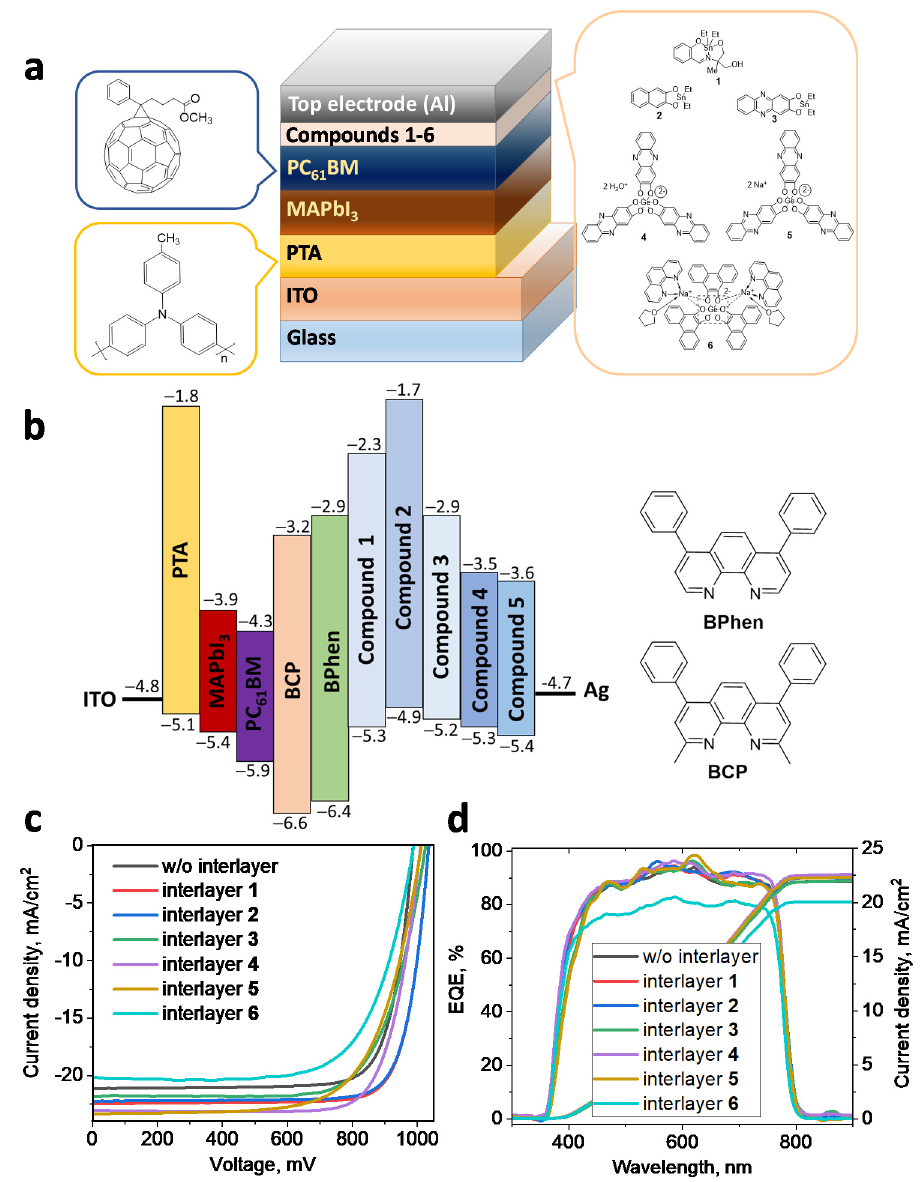
Figure 3. Schematic layout of the perovskite solar cell architecture, using complexes 1 – 6 as interlayer materials between PC 61 BM and Al ( a ); energy level diagram for used device components ( b ); J -V curves ( c ); and EQE spectra ( d ) of the best-performing solar cells, using 1 – 6